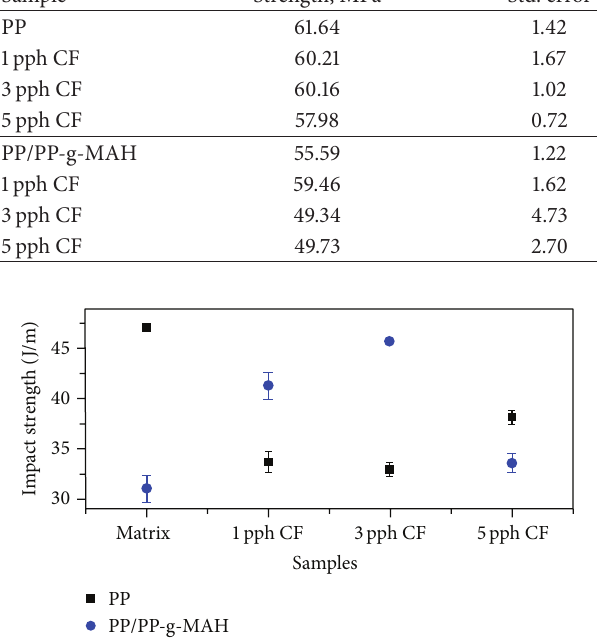
Figure 5: Izod impact test values of the injection moulded